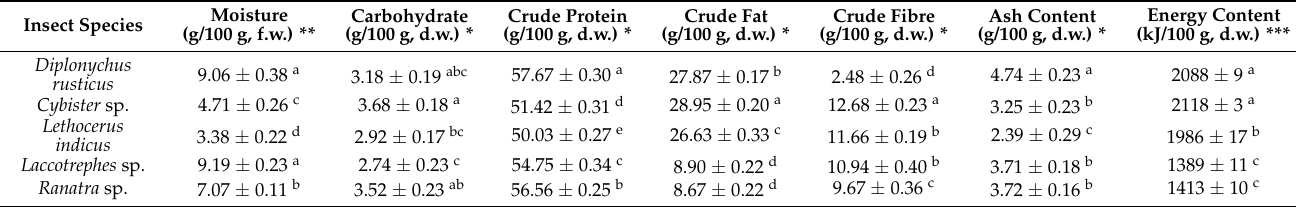
Table 1. Proximate composition of the five aquatic insect species 1 .